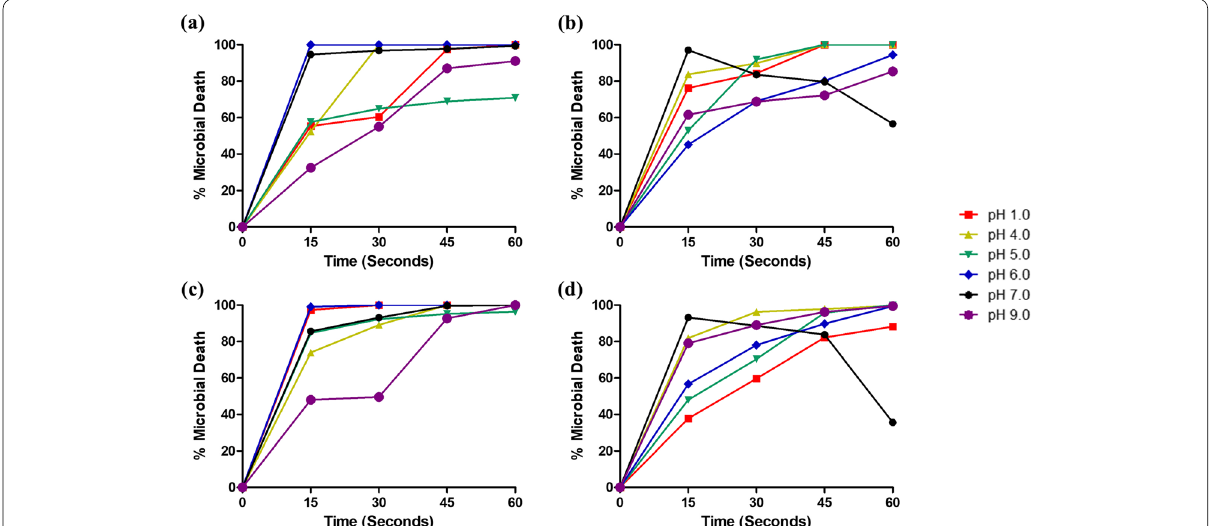
Fig. 1 Effect of varying the pH on the percentage microbial death (mean aureus (Et); b 85% isopropyl alcohol (IPA), S. aureus ; c 85% ethanol (ET), E. coli ; and d 85% isopropyl alcohol (IPA), E. coli. N